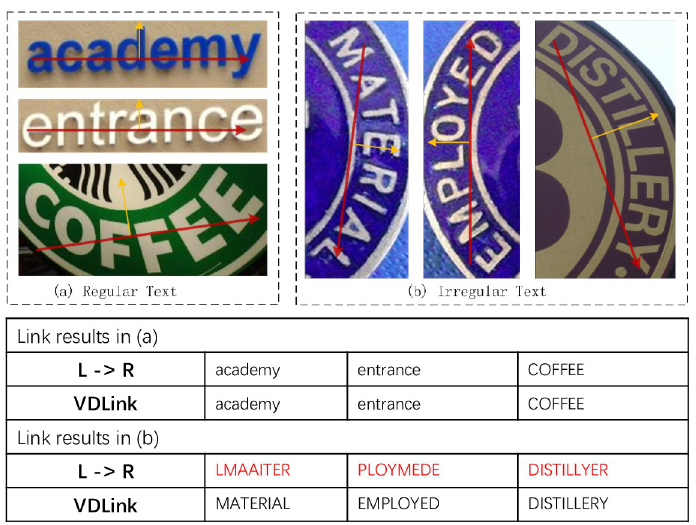
Fig 7. The result of using VDLink and left-to-right strategy on regular and irregular text. Reprinted from [19] under a CC BY license, with permission from IJDAR, original copyright 2020.